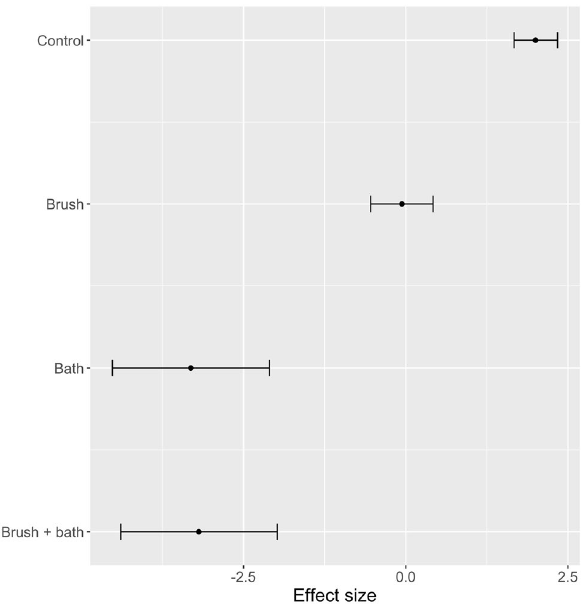
Figure 14. Effect size (estimate and 95% confidence interval of generalised linear mixed models) for components of Equipment 2 across all soil and moisture types: Control = no hygiene; Brush = brushing with a set of fixed boot brushes; Bath = immersing the soles of boots in 10% BAC; 95% confidence intervals that do not overlap can be considered significantly different. Positive effect values indicated that treated boots retained P. cinnamomi